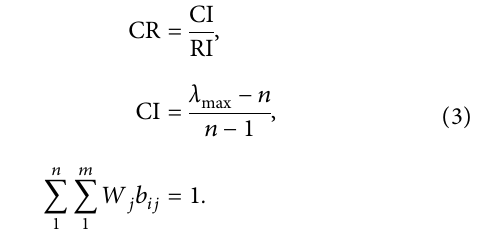
Figure 3: Three-dimensional scatter diagram between the density of accounting risk sources, accounting and financial parameters, and the big data